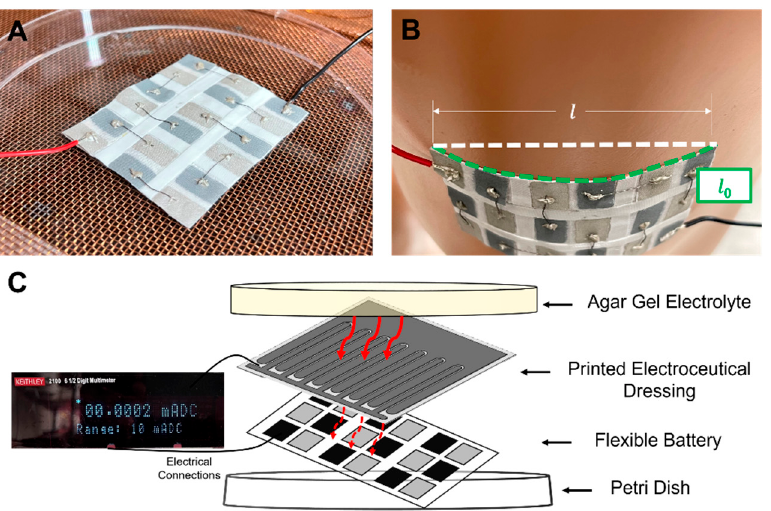
Figure 2. ( A ) Experimental setup of the nine-cell battery in an unstrained state in the Faraday cage. ( B ) Experimental setup of the nine-cell battery on the quadricep of the mannequin with a visual of the length dimensions used to calculate the strain. ( C ) Exploded view of the agar gel, PED [1], and flexible battery to depict the current flow that was measured experimentally with the Keithley 2100